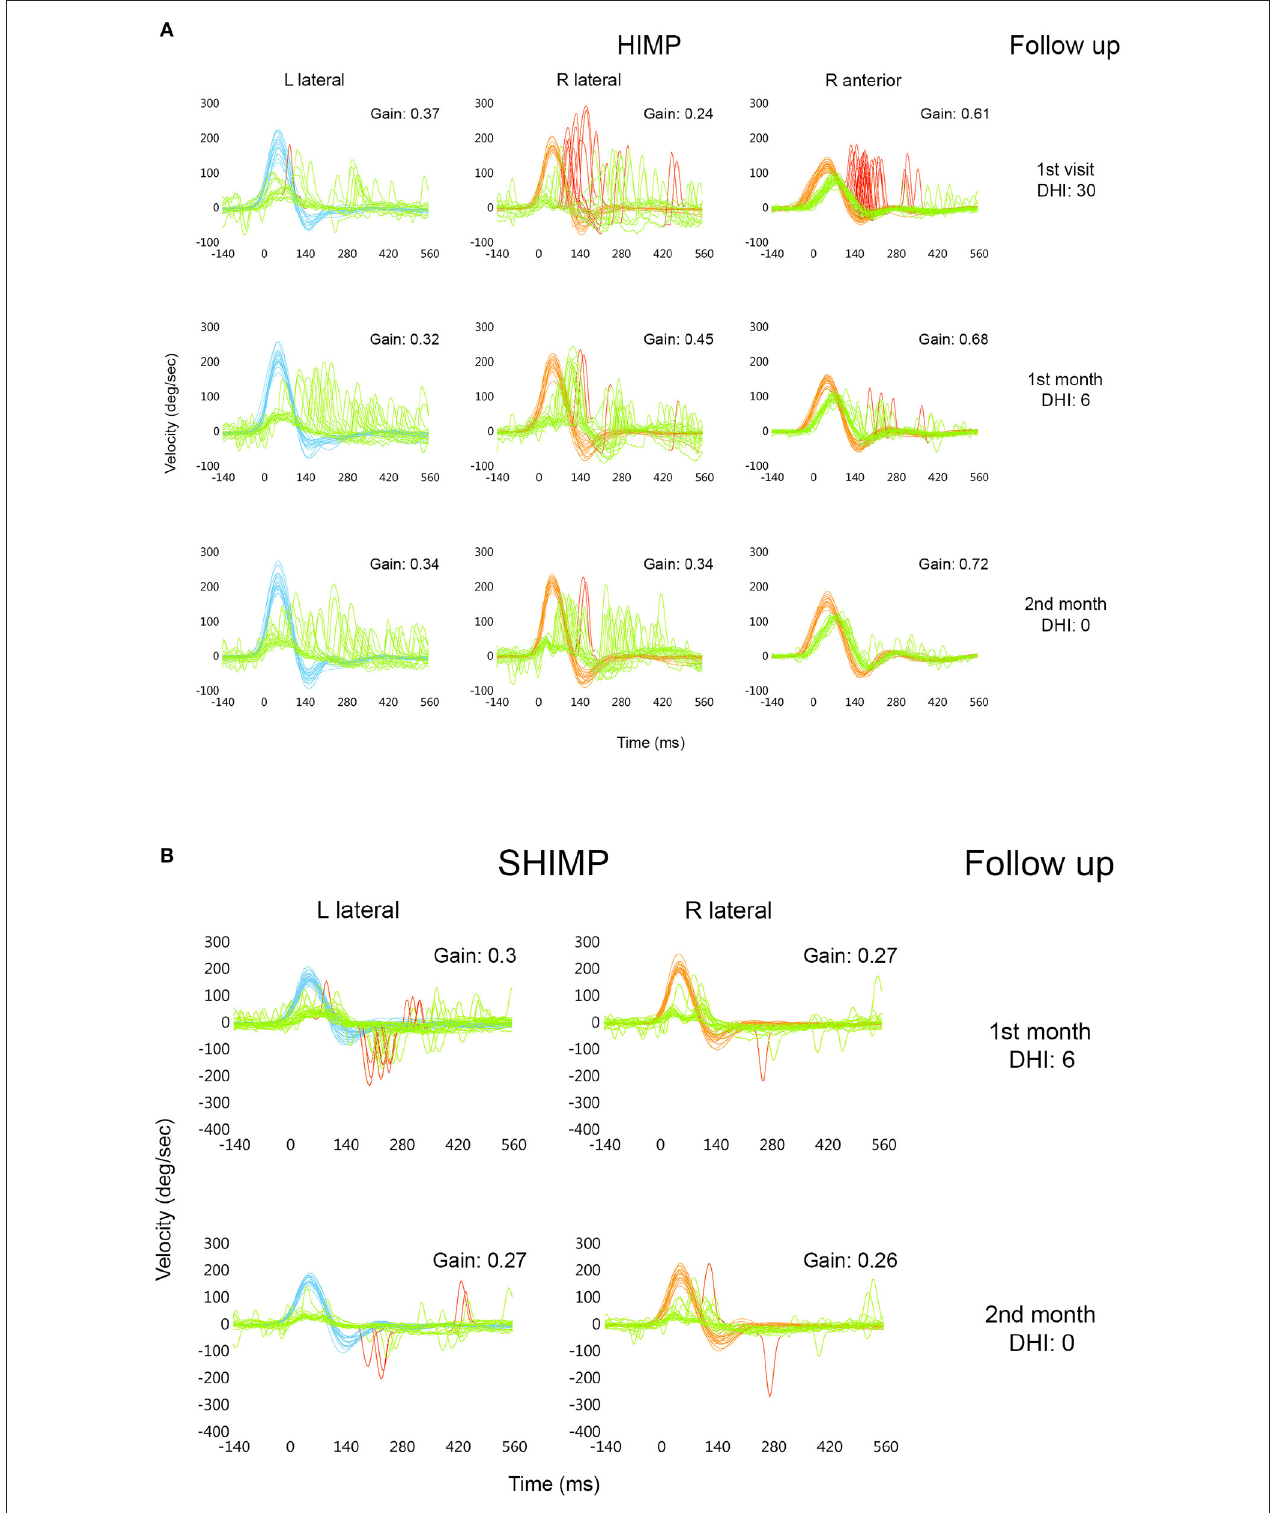
FIGURE 3 | vHIT comparative superimposed head [right: red; left: blue] and eye [green] velocity in degrees/second ( y axis) vs. time in ms ( x axis), during HIMP trials of both lateral SCCs and of the R anterior SCC including VOR mean gain values, obtained at the 1st visit and at the 1st and 2nd month of follow-up with DHI scores (right column); “Spontaneous Nystagmus” check box not selected (A) . Similar vHIT comparative superimposed head and eye velocity in degrees/second ( y axis) vs. time in ms ( x axis) during SHIMP trials obtained at the 1st and 2nd month of follow-up with DHI scores (right column); “Spontaneous Nystagmus” check box not selected (B) .